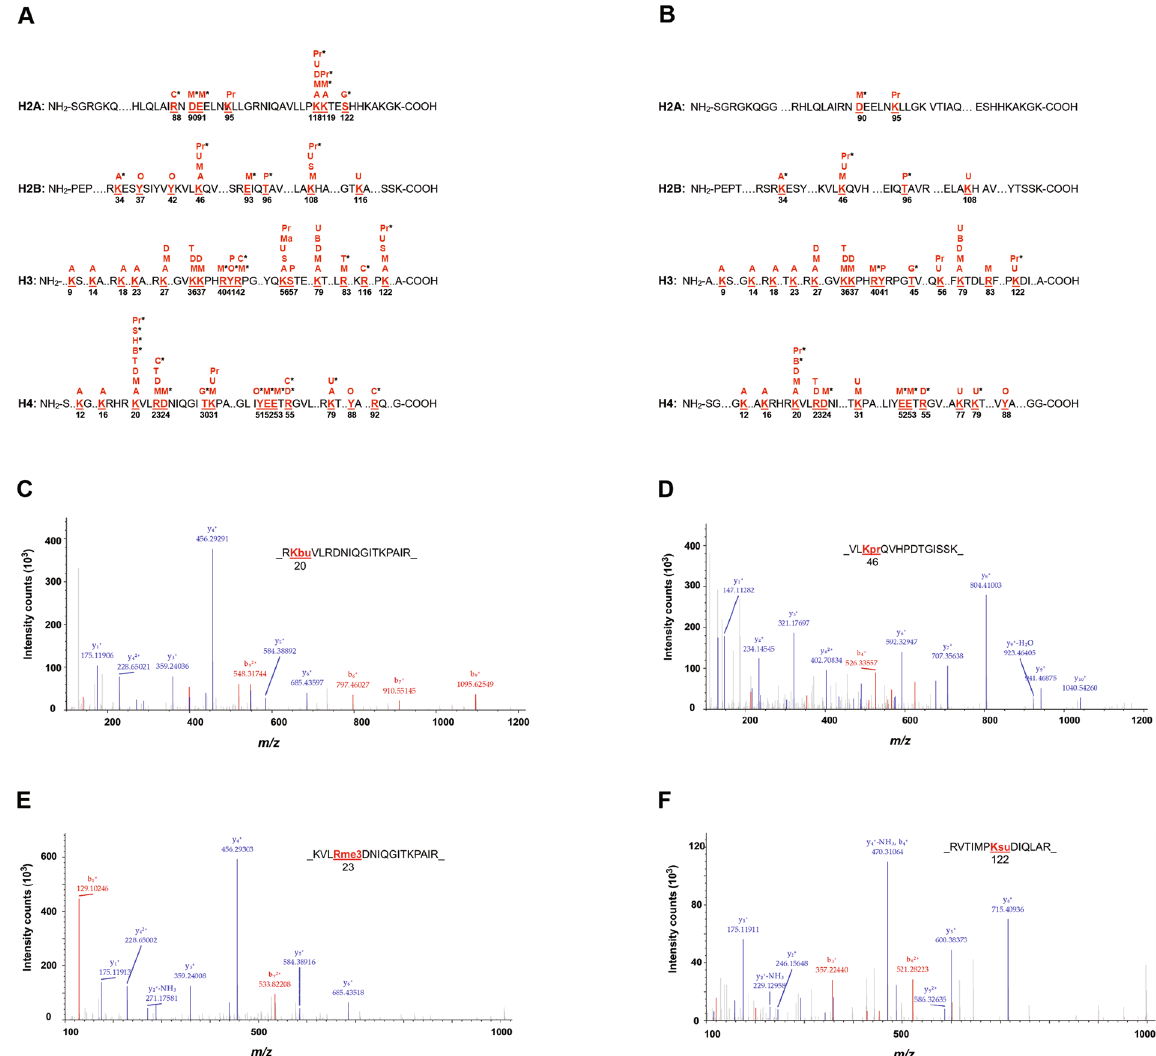
Figure 4. Identification of post-translational modification (PTM) residues in core histone proteins of bladder cancer cells following heat shock protein 90 inhibitor treatment. The illustration of identified PTM sites on the core histones in 5637 cells in response to AUY922 ( A ) and ganetespib ( B ) exposure. The identified PTM sites on the core histones are numbered and highlighted. * Indicates novel histone marks identified in this study. A , acetyl; B , butyryl; C , citrulline; D , dimethyl; G , O -GlcNAcyl; H , 2-hydroxyisobutyryl; M , monomethyl; Ma , malonyl; O , oxidation; P , phosphoryl; Pr , propionyl; S , succinyl; T , trimethyl; U , ubiquityl. ( C ) An MS/ MS spectrum of a tryptic peptide histone H4K20 lysine-butyrylated peptide _RK(bu)VLRDNIQGITKPAIR. ( D ) An MS/MS spectrum of a tryptic peptide histone H2BK46 lysine-propionylated peptide _VLK(pr) QVHPDTGISSK. ( E ) An MS/MS spectrum of a tryptic peptide histone H4R23 arginine-trimethylated peptide _KVLR(me3)DNIQGITKPAIR. ( F ) An MS/MS spectrum of a tryptic peptide histone H3K122 lysine- succinylated peptide